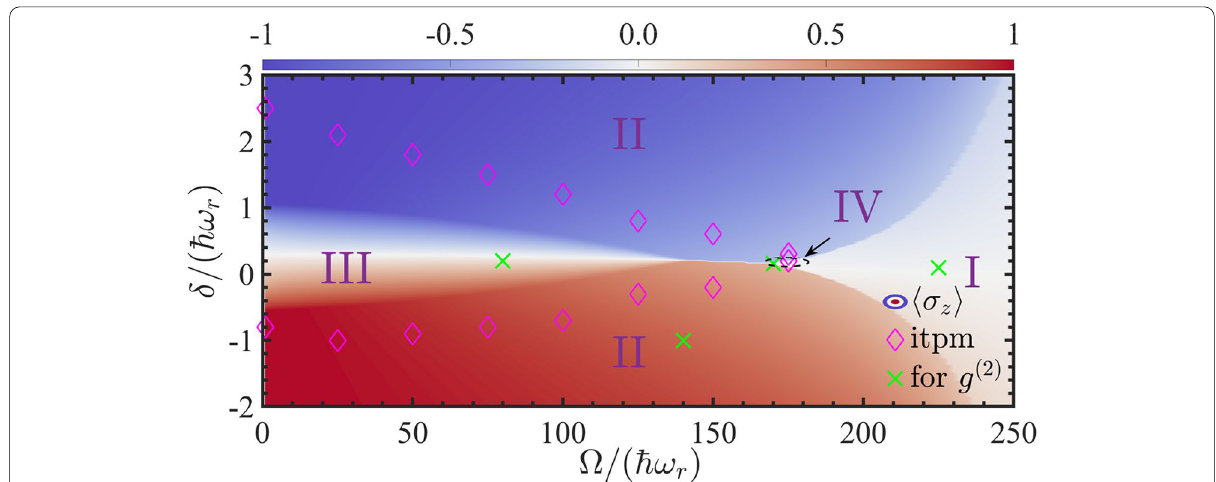
Fig. 7 A typical phase diagram in the δ ‑ (cid:31) plane of a SOAM‑coupled 41 K gas with inter‑ and intra‑species interactions modulated by the Feshbach resonance technique. The color indicates the expectation value of spin magnetization variational approach. The magenta diamonds indicate the regime of angular stripe phase III determined by another imaginary‑time propagation method (itpm). The green crosses indicate the selected positions for four distinct phases in Fig. 5, respectively. Here, the Roman numbers stand for the same phases as those in Fig. 5. Adapted from Ref.